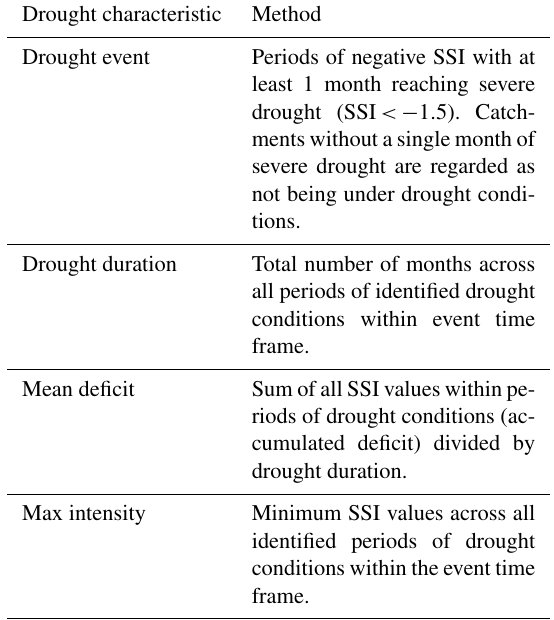
Table 2. Drought characteristics considered in this study and their derivation